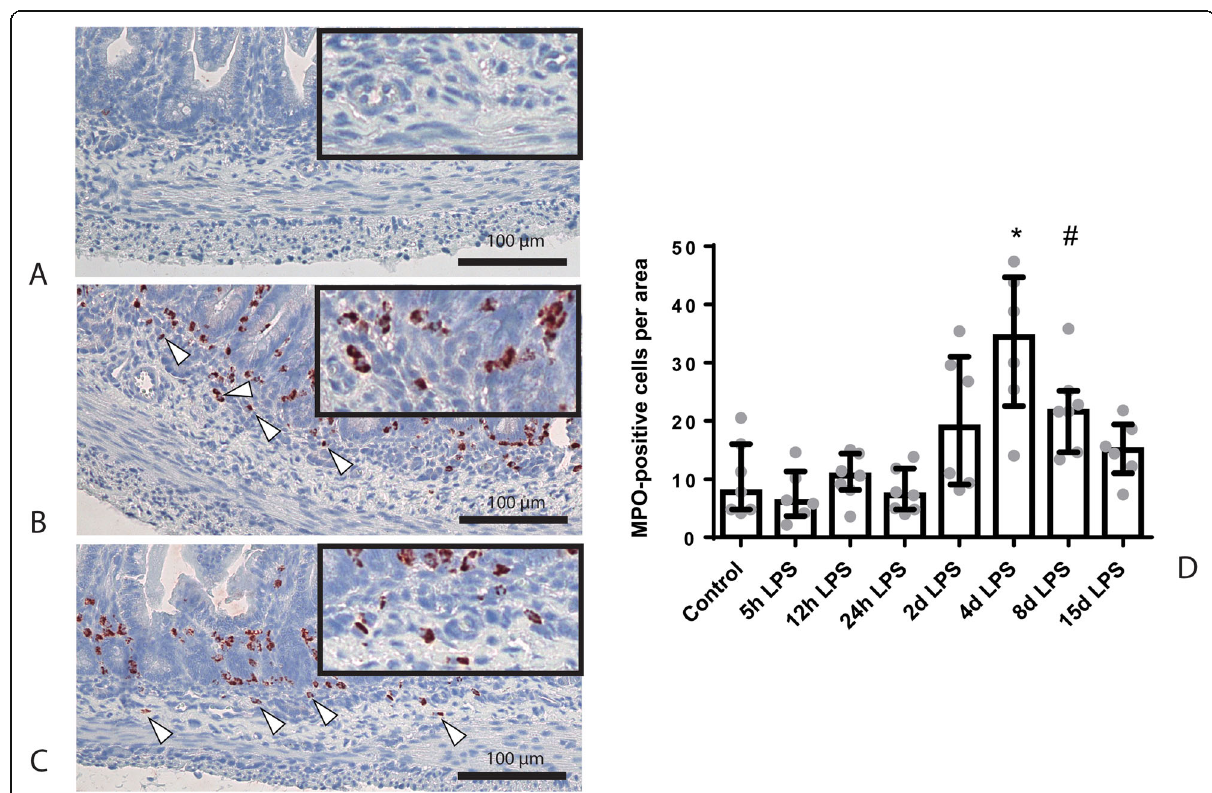
Fig. 2 Representative images of submucosal neutrophil influx reflected by MPO-positive cell (indicated by white triangles) counts of the control ( a ), 4 days of IA LPS ( b ) and 8 days of IA LPS group ( c ). d Increased MPO count in animals exposed to 4 and 8 days of IA LPS. * p < 0.01 compared to control. # p = 0.08 compared to